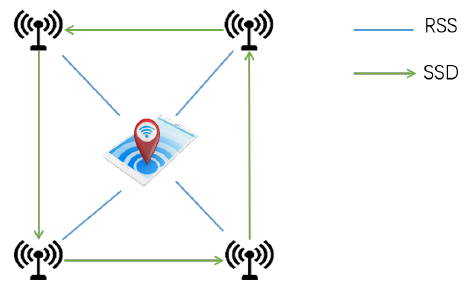
Figure 2. The usage of RSS and SSD from multiple